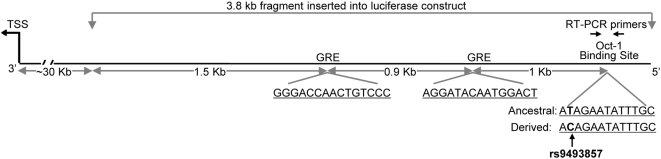
Cartoon of the 3.8 kb enhancer region located 30 kb upstream of the SGK1 TSS.The entire 3.8 kb enhancer region was used in the reporter gene experiments. The cartoon also shows the predicted GREs, the position of rs9493857 (red) in the predicted Oct1-binding site, and the location of the primers used to evaluate the results of the ChIP experiments.